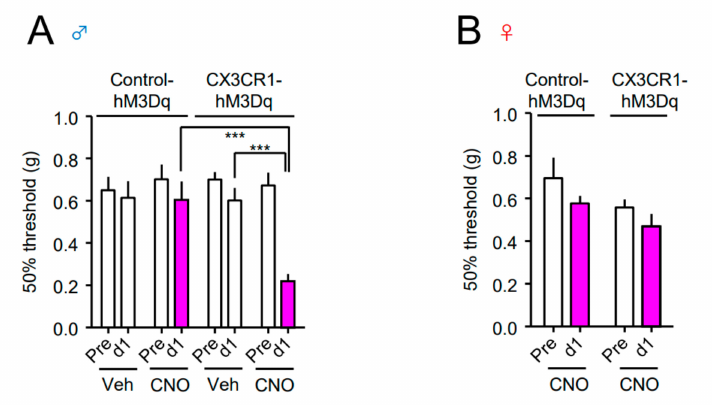
Figure 2. Induction of mechanical allodynia by CNO in male CX3CR1-hM3Dq mice. ( A , B ) CNO (2 nmol) or vehicle (Veh) was intrathecally (i.t.) administered to naïve Control-hM3Dq and CX3CR1-